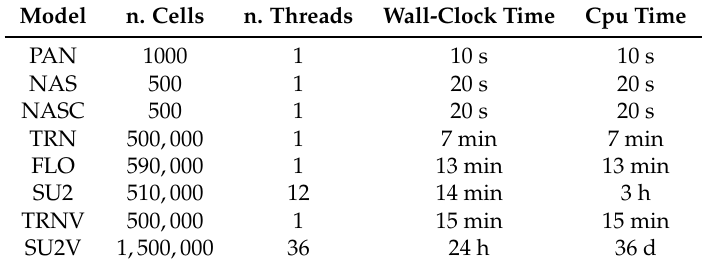
Table 5. Mesh size and computational time required by the different models for the Onera M6 benchmark case.